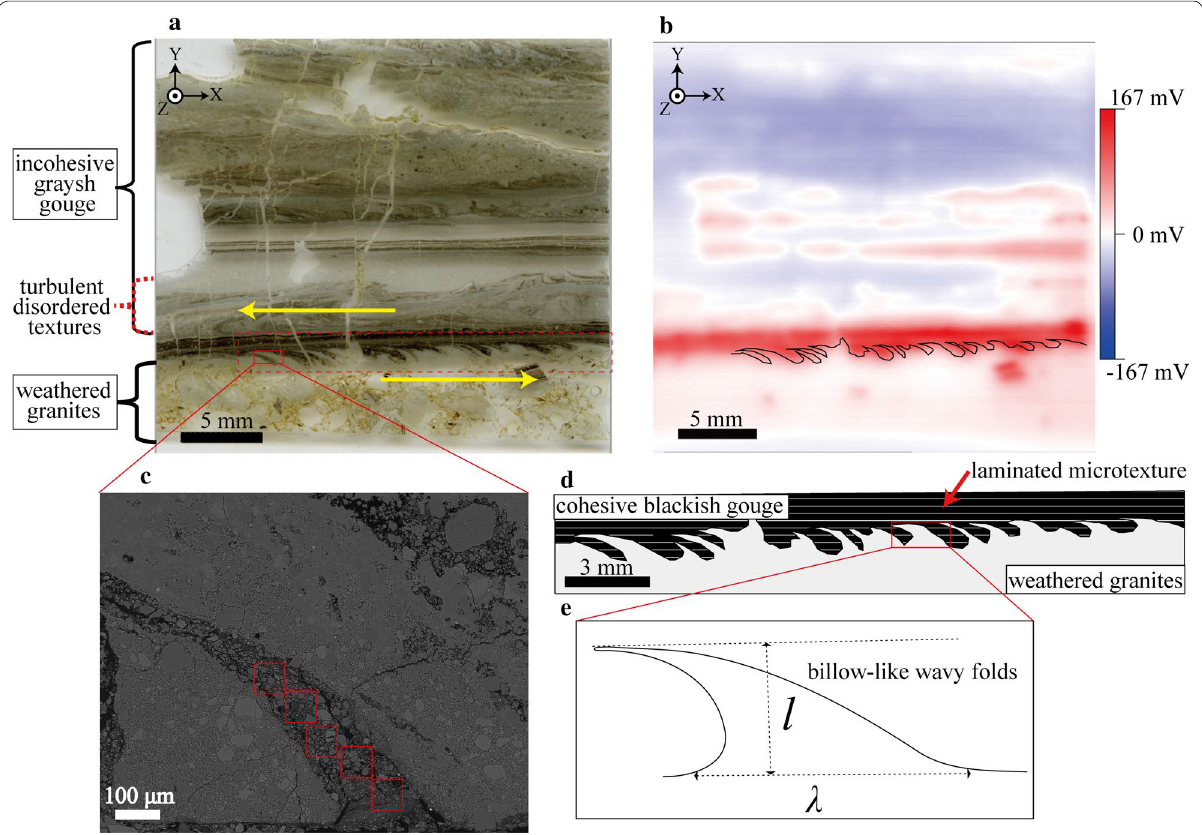
Fig. 2 a Optical image of a thin section from block sample 5 in Fig. 1d. The fault gouge consists of three parts, incohesive grayish gouges, cohesive blackish gouges, and weathered granites. The microstructure shows turbulent disordered textures, laminated textures, and billow-like wavy folds. b Surface magnetic field distribution of the thin-section sample observed under the MI magnetic microscope after imparting IRM at 1 T. White regions correspond to near-average magnetic field, and red ( blue ) regions correspond to upward ( downward ) oriented fields. The voltage is proportional to the magnetic field detected by the MI sensor. c Backscattered electron (BSE) image of the billow-like wavy folds in the solid red rectangle in ( a ). d Schematic of the billow-like wavy folds in the red dashed rectangle in ( a ), which are generated between the cohesive blackish gouge and the weath- ered granites. e Definition of width ( l ) and wavelength (λ) of the billow-like wavy